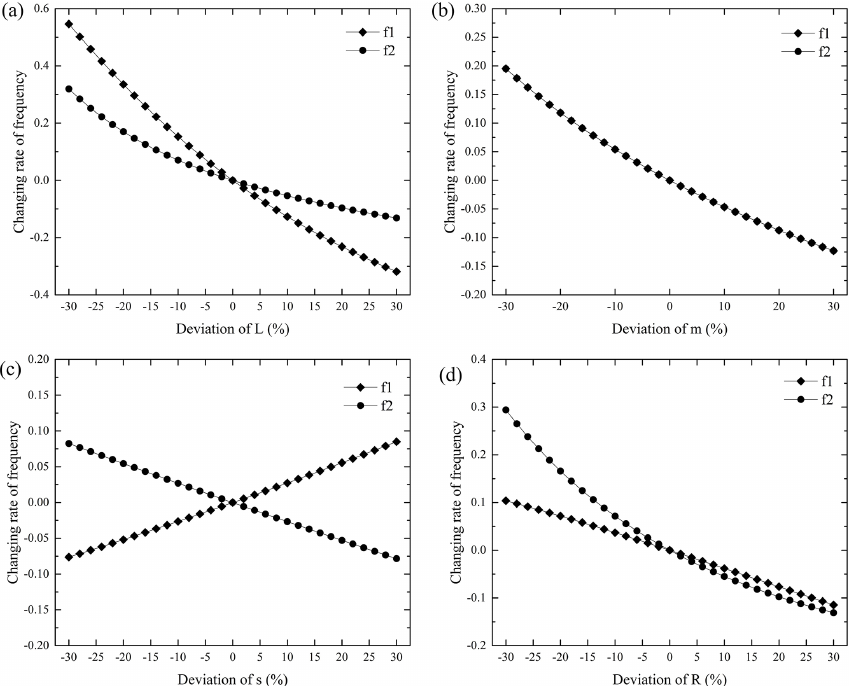
Figure 6. Changing rates of the natural frequencies with the changes of vibration damper’s structural parameters: (a) L changes, (b) m changes, (c) s changes, (d) R